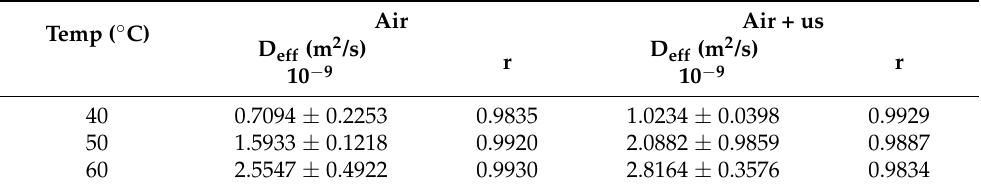
Table 2. Effective diffusivity ( D eff ) identified for the drying of henna leaves at different temperatures, without and with ultrasound (21.7 kHz, 20.5 kW/m 3 ) (mean ± SD). Air Air + Temp ( ◦ C)